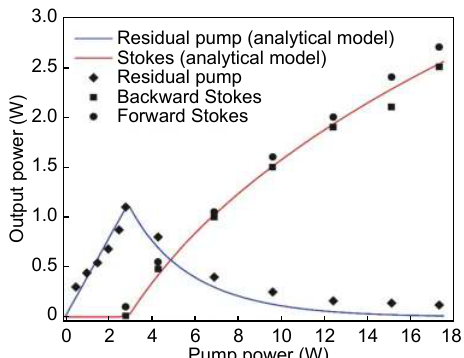
Fig. 13 | 7-core Raman fiber laser power characteristics: output power of the backward Stokes (■), forward Stokes (●) and trans- mitted pump power (♦) as a function of input pump power. Red line is the result of numerical simulations for Stokes generation, blue line − numerical simulations for transmitted pump power.